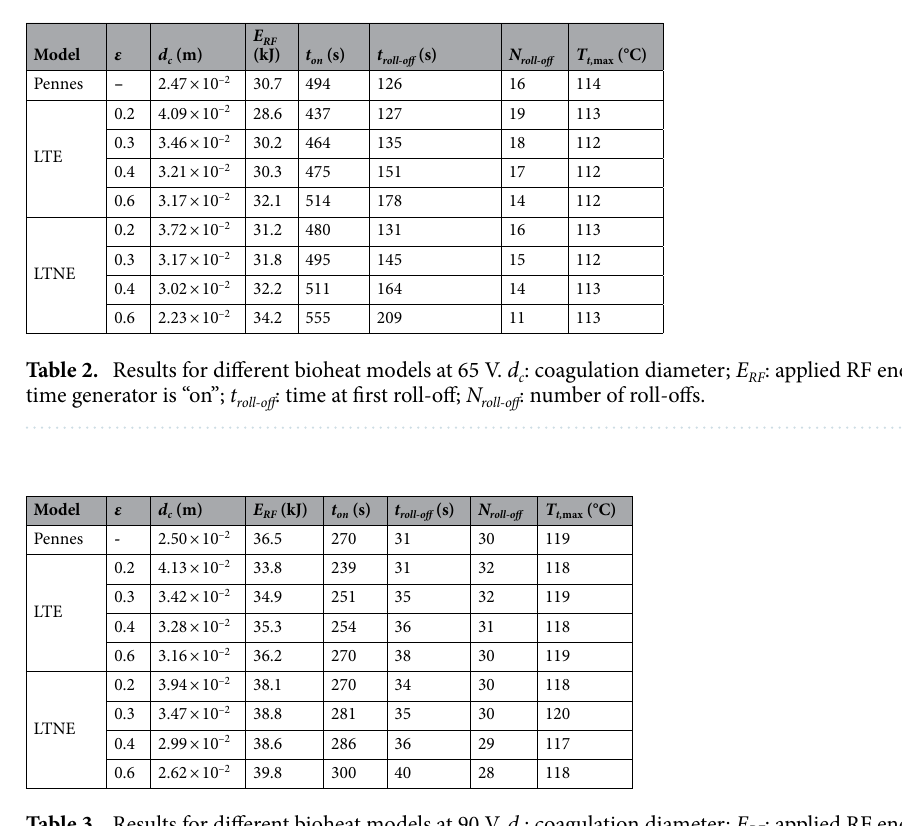
Table 3. Results for different bioheat models at 90 V. d c : coagulation diameter; E RF : applied RF energy; t on : total time generator is “on”; t roll-off : time at first roll-off; N roll-off : number of roll-offs.